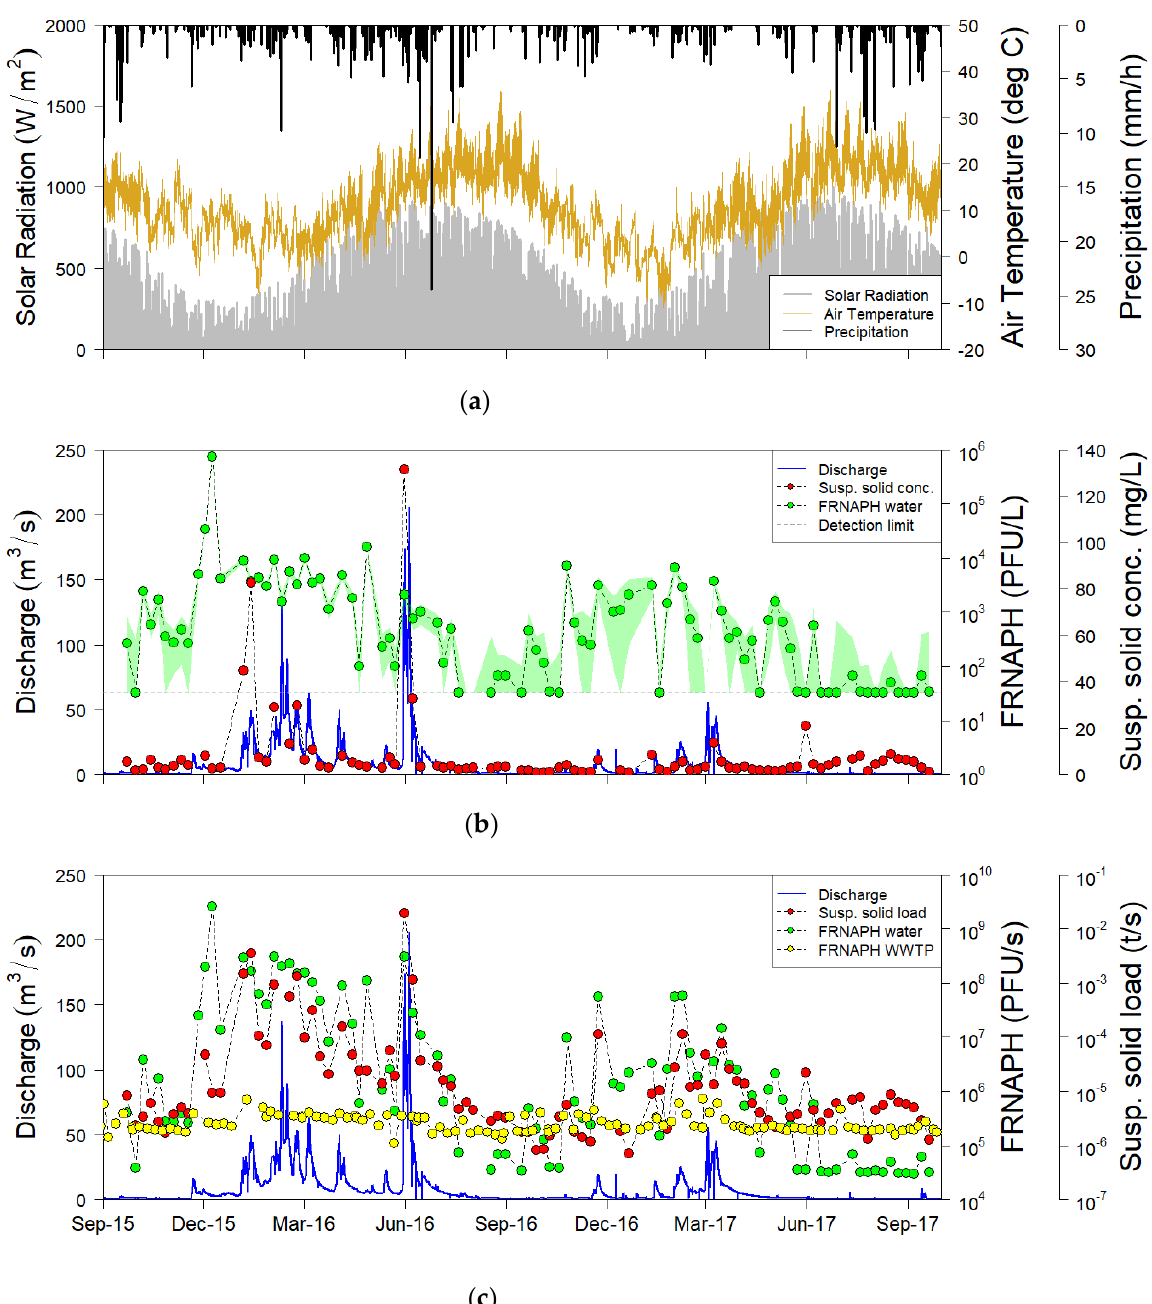
Figure 3. ( a ) Solar radiation, air temperature and rainfall measured at the M é teo France station A é roport M.N.L., ( b ) river discharge, weekly F-specific RNA bacteriophage (FRNAPH) and suspended solid concentrations in the Orne River basin recorded at the Beth sampling site. The green shadows represent the 95% confidence interval for the FRNAPH measurements. The dashed grey horizontal line shows the FRNAPH limit of quantification. ( c ) Suspended solid and FRNAPH fluxes at Beth and FRNAPH flux from the wastewater treatment plant (WWTP) located 0.9 km